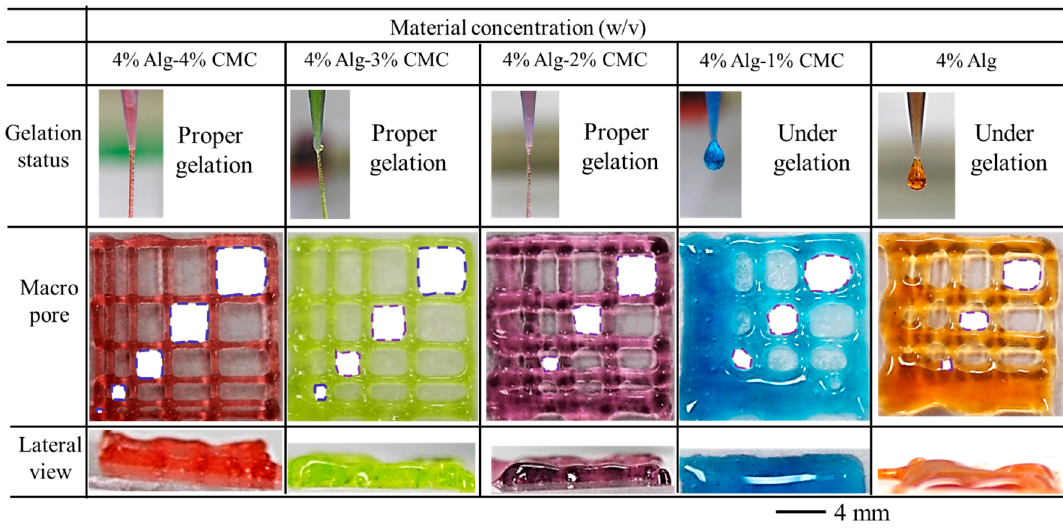
Figure 10. Filament fusion test.